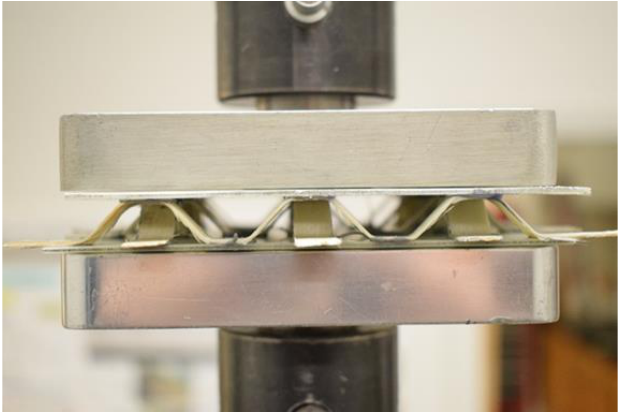
Figure 17. Compression Modulus Test Configuration.